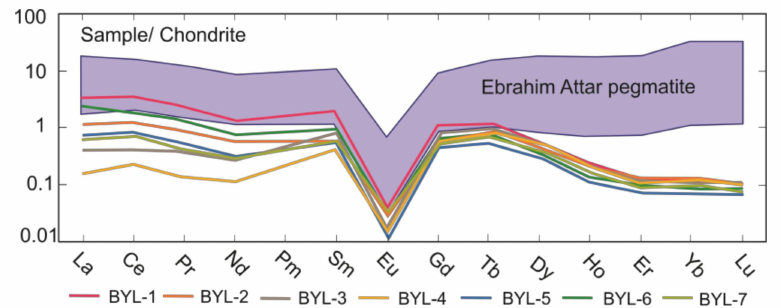
Figure 5. Chondrite-normalized rare earth element (REE) patterns of the Ebrahim-Attar beryl samples based on Sun and McDonough [44]. Data for the Ebrahim-Attar pegmatite are from Azizi et al. [30].